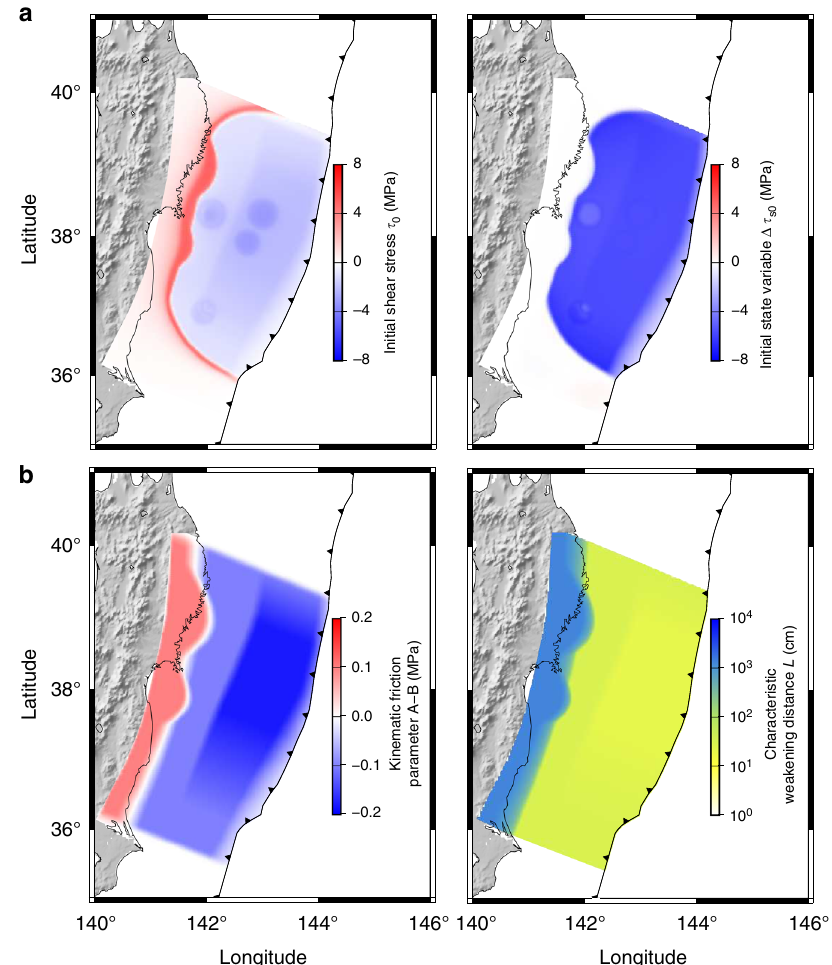
Fig. 2 The variables and parameters that are taken over from a simulated M w 9 earthquake scenario produced by a past study. a Shear stress ( τ ) and state variable ( Δ τ ) used as the initial values. The initial value of slip velocity ( V ) is calculated using these values with Eq. (3). b Frictional parameters. Afterslip occurs mainly in the area where A − B is positive and L is large